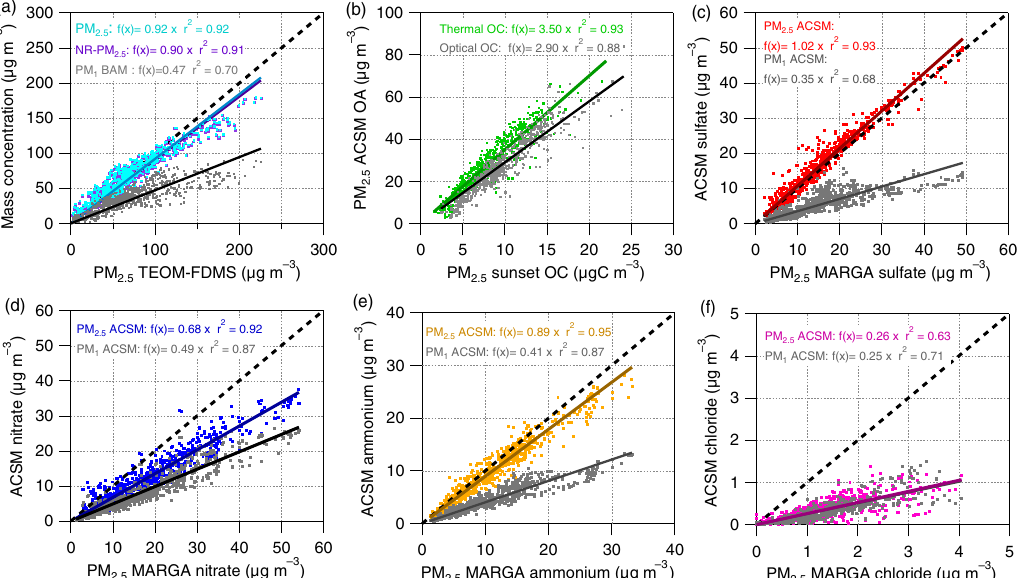
Figure 3. Scatter plots with the linear regression parameters and the 1 : 1 line (dashed line) are shown for the comparisons. Note that the term of “PM 2 . 5 ” in the plot of panel (a) indicates the summed mass concentration of the PM 2 . 5 -ACSM species (organics, nitrate, sulfate, ammonium, and chloride), Sunset EC, and MARGA species (K + , Na + , Mg 2 + , and Ca 2 + ). Also note that the difference observed between “thermal” and “optical” PM 2 . 5 OC measurements (b) might be related to poor calibration of the oven temperature probe (e.g., Panteliadis et al., 2015), which could not be checked before nor after the